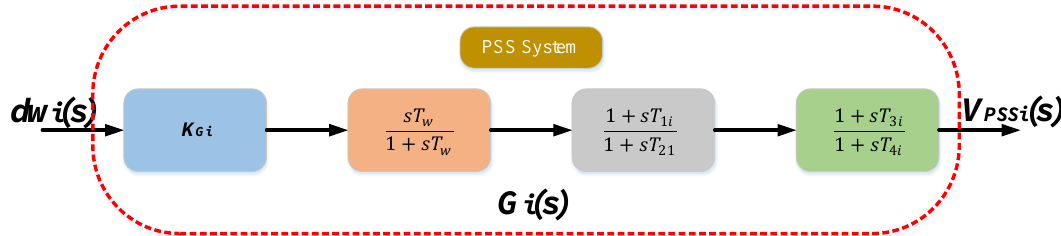
Figure 16. A lead – lag PSS [35]. Figure 16. A lead–lag PSS